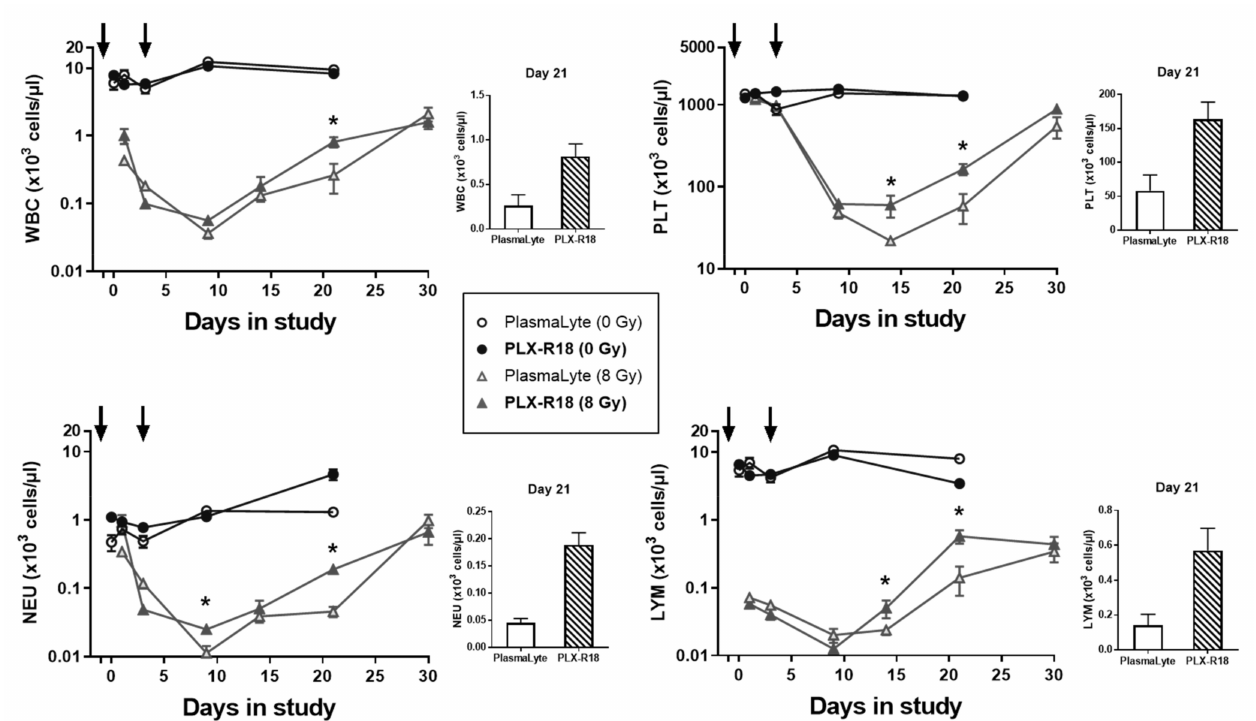
Figure 2. Recovery of peripheral blood cells [white blood cells (WBC), neutrophils (NEU), platelets (PLT), and lymphocytes (LYM)] of unirradiated mice treated with vehicle PlasmaLyte ( R18 ( • ) and irradiated (8 Gy) mice treated with PlasmaLyte ( ∆ ) and PLX-R18 ( (cid:78) ). Either PlasmaLyte or PLX-R18 (2 million cells/dose) was administered (IM) 24 h prior to and 3 days post-TBI (indicated by arrows). Day 0 represents day of irradiation. Data represented are mean ± standard error of the mean (SEM) for n = 8 mice. Significant difference ( p < 0.005–0.0125) between PLX-R18-treated and vehicle-treated irradiated group by ANOVA is indicated with an asterisk (*). Some data points in the figure do not have error bars that are visible because they are smaller than symbols. Bar graphs show the most significant data (day 21 post-TBI) for each of the cell